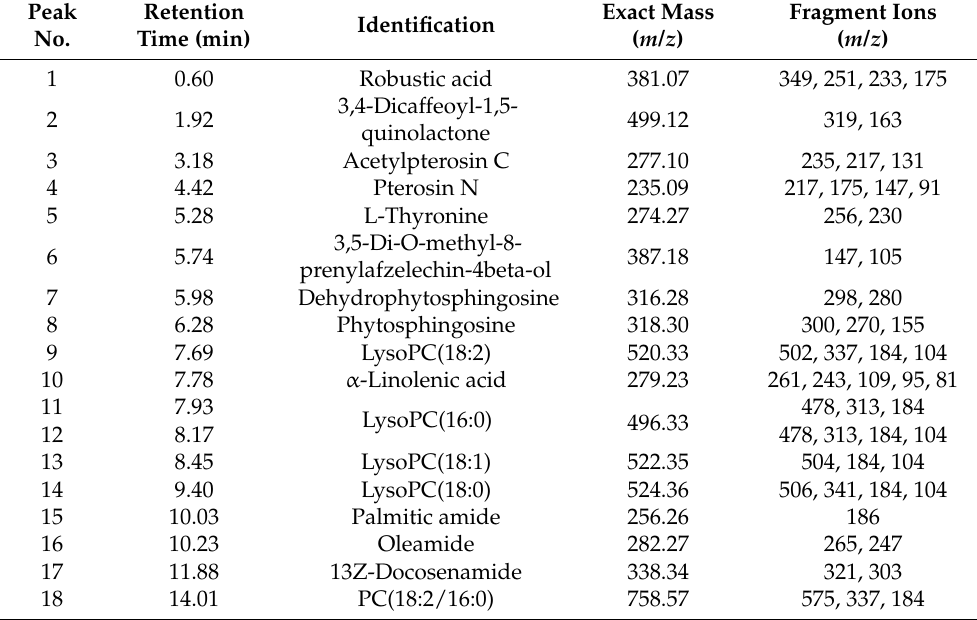
Table 1. Metabolites of extract (AYC-CS-E) isolated from culture supernatant of Aster yomena callus an- alyzed by electrospray (ESI)-positive mode in ultra-performance liquid chromatography-quadrupole- time-of-flight mass spectrometry